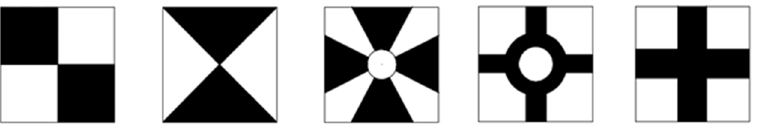
Table 2. Camera calibration parameters.